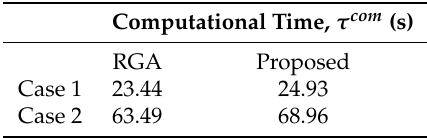
Table 5. Comparison of the computational time incurred by all compared methods.